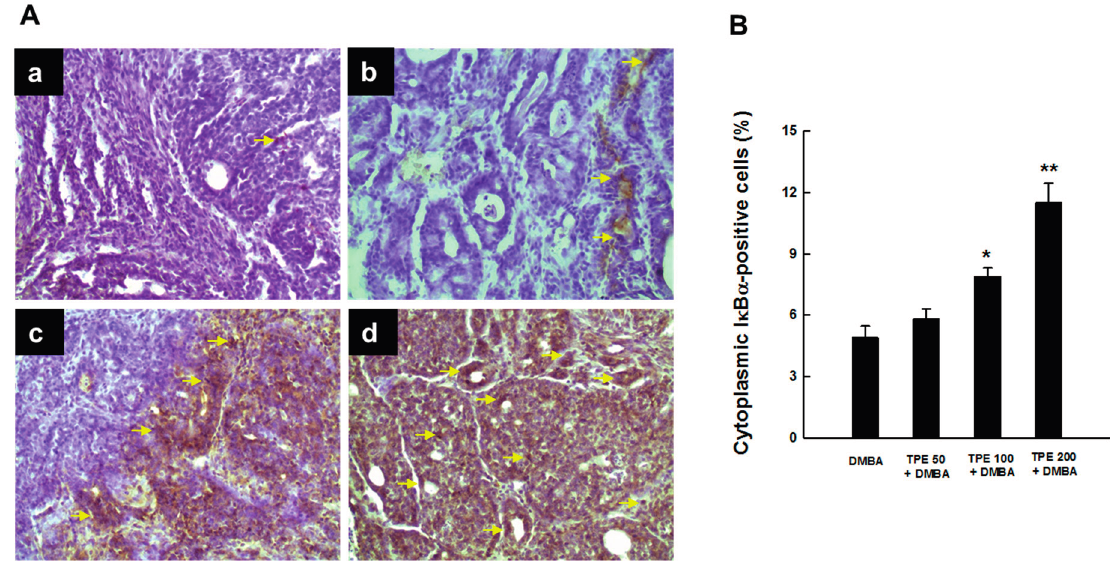
Figure 4. The immunohistochemical expression of I κ B α during DMBA-evoked mammary neoplasia in rats in the presence or absence of TPE. The animals were treated as indicated in the legend to Figure 1. The mammary tumor sections were subjected to immunohistochemical analysis using anti-I κ B α antibody. ( A ) Immunohistochemical localization of I κ B α -positive cells in tumor samples. Arrows indicate immunohistochemical staining of I κ B α in cytoplasm (magnification: × 200). Various treatment groups are: ( a ) DMBA control; ( b ) TPE (50 mg/kg) plus DMBA; ( c ) TPE (100 mg/kg) plus DMBA;